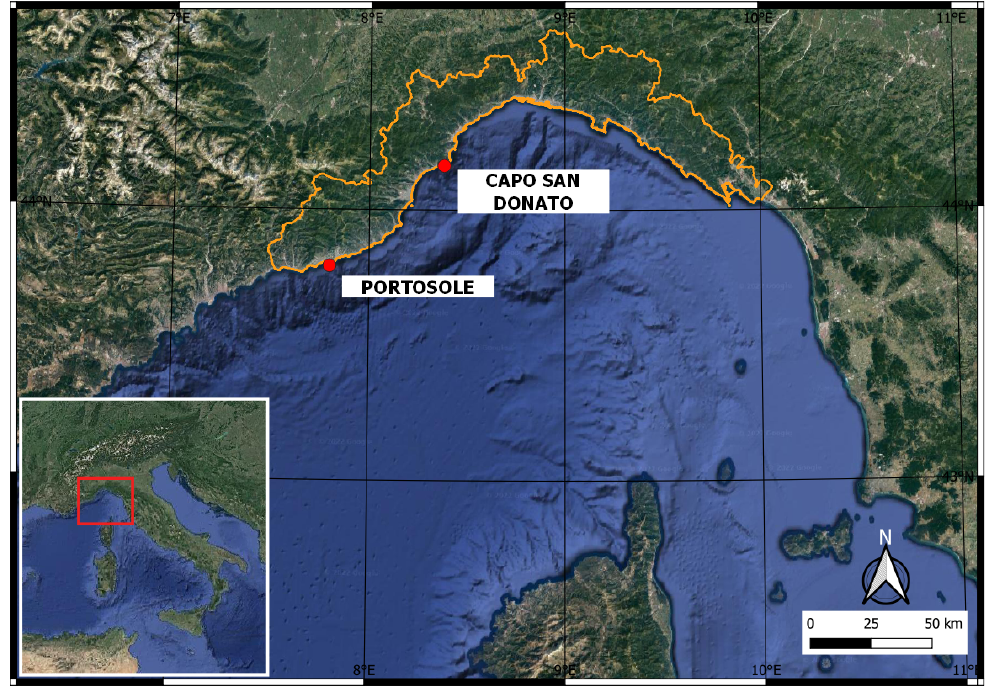
Figure 1. Study areas in Liguria, Italy: Capo San Donato marina in Finale Ligure and Portosole marina in Sanremo (Google Satellite as